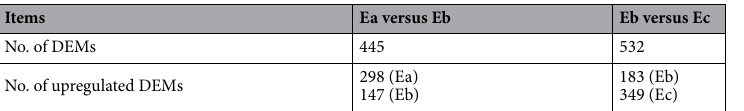
Table 1. Comparison of different metabolites in serum (false discovery rate (FDR) < 0.05, variable importance in the projection (VIP) > 1, fold change (FC) > 2, or FC < 0.5, differentially expressed metabolites (DEMs), serum (E), a: feeding period, b: fasting period, c: recovery feeding